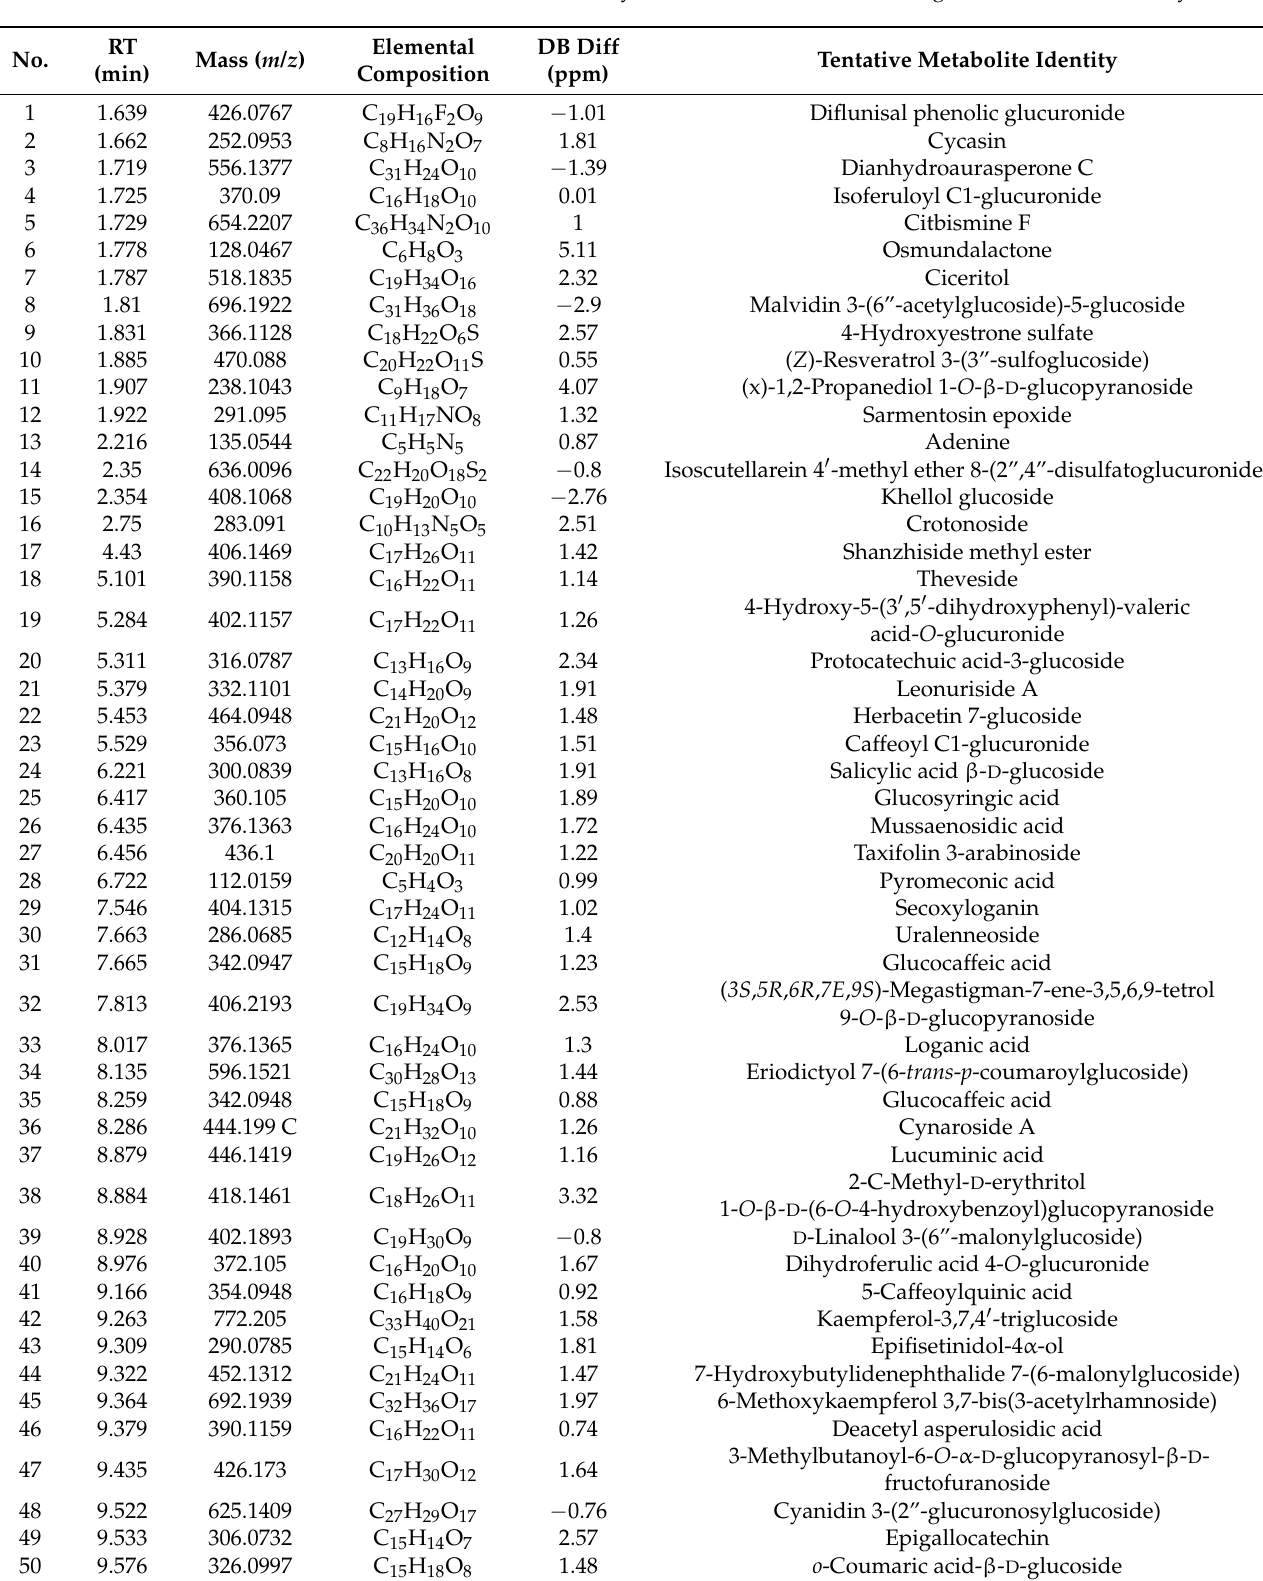
Table 1. Constituents tentatively identified in MSE extract using LC-ESI-QTOF-MS